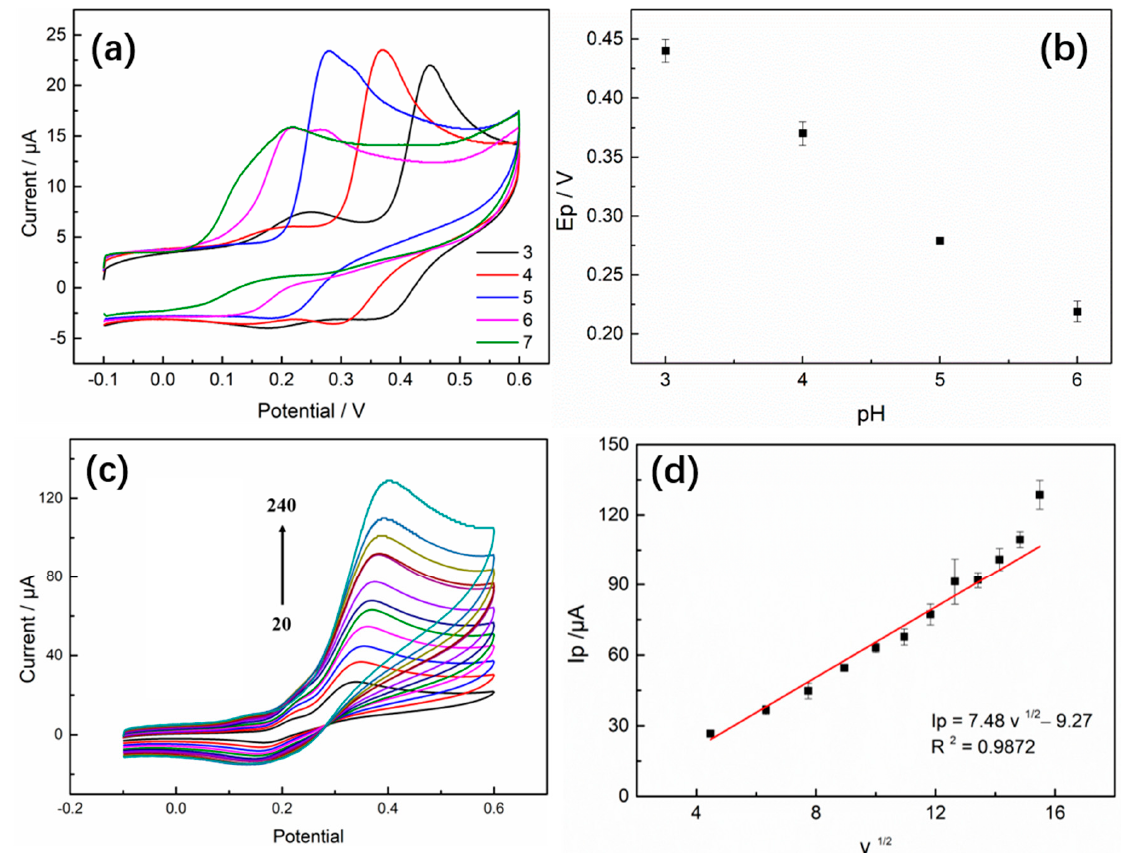
Figure 5. ( a ) CV curves of Co-MOF/CNTs/SiO 2 /AuE in solutions containing 0.1 mM GA at different pH values; ( b ) the relationship of peak potentials and pH values; ( c ) CV curves of Co- MOF/CNTs/SiO 2 /AuE at different scan rates ranging from 20 to 260 mV s − 1 ; ( d ) the relationship of peak current and scan rates.